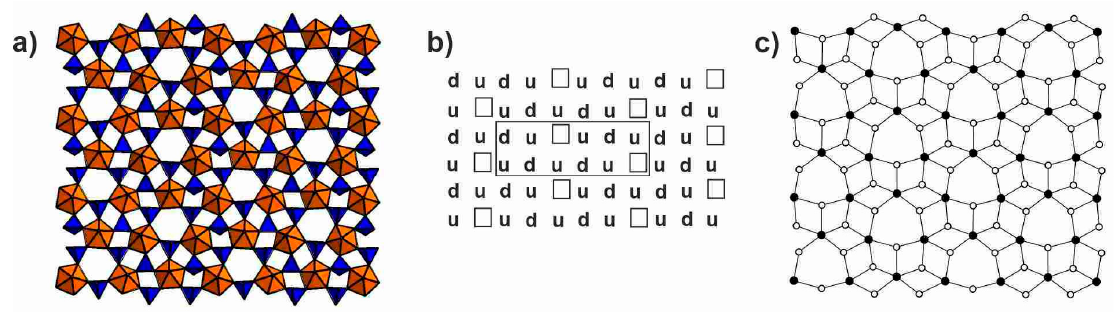
Figure 3. ( a ) The [(UO 2 ) 3 (MoO 4 ) 5 ] 4 − layer in the structure of 1 ; ( b ) orientation matrix of the terminal oxygen atoms (non-shared vertices of MoO 4 tetrahedra), and ( с ) the corresponding graph.